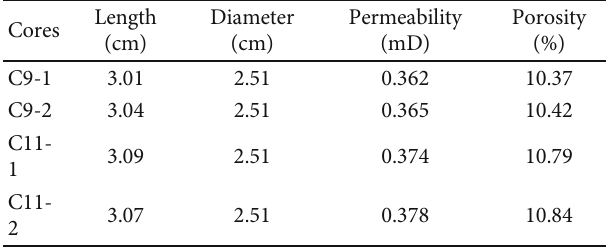
Figure 1: Illustration of the cores and slices. Table 2: Basic core information.